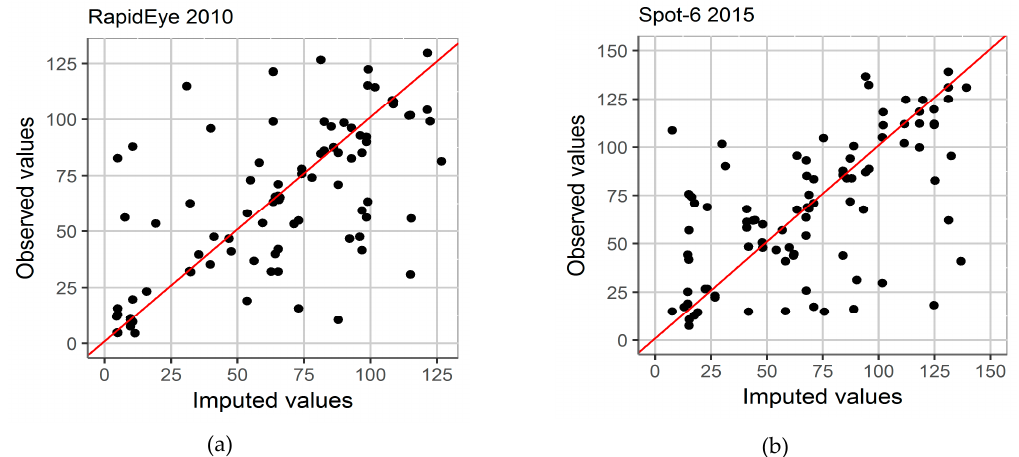
Figure 6. Scatterplots of imputed versus observed values of total carbon stock according to k -Nearest Neighbors ( k -NN) prediction, t C year − 1 : ( a ) prediction based on RapidEye image for 2010; ( b ) prediction based on SPOT 6 image for 2015. The red lines indicate 1:1 relationship.